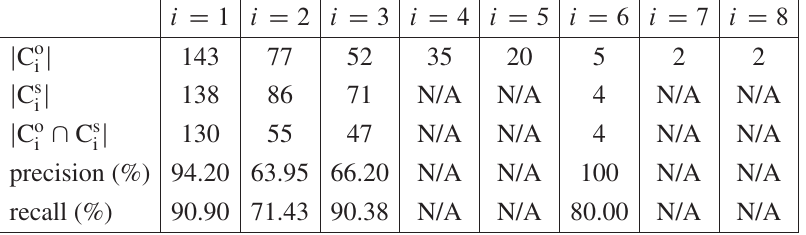
Table 4. Clustering result of our approach for Ecoli